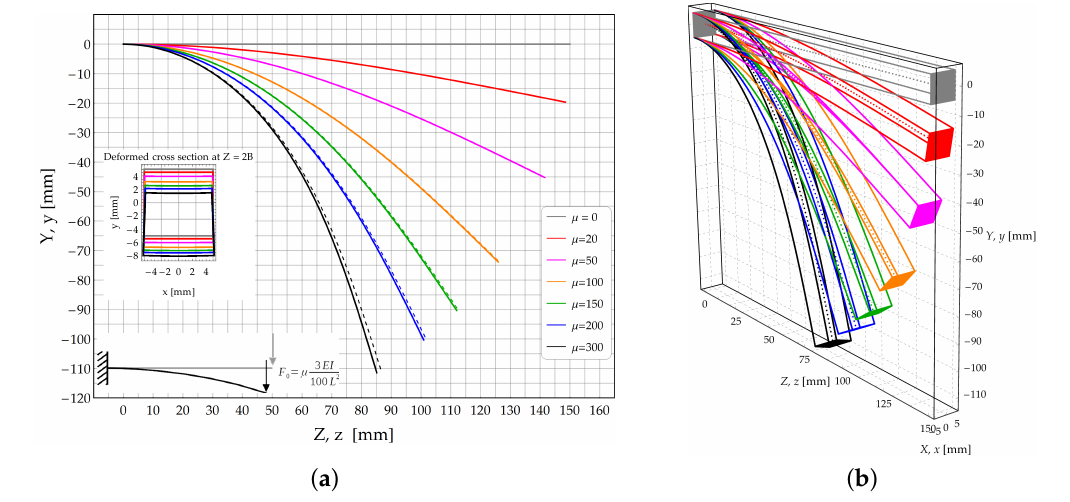
Figure 8. Study case A 2 : Cantilever beam subjected to a transverse dead load acting at its free end. ( a ) Deformed configuration of the longitudinal axis: Theoretical model (continuous lines) and FE model (dashed lines); ( b ) 3D skecth of the deformed configurations obtained by the theoretical solution.